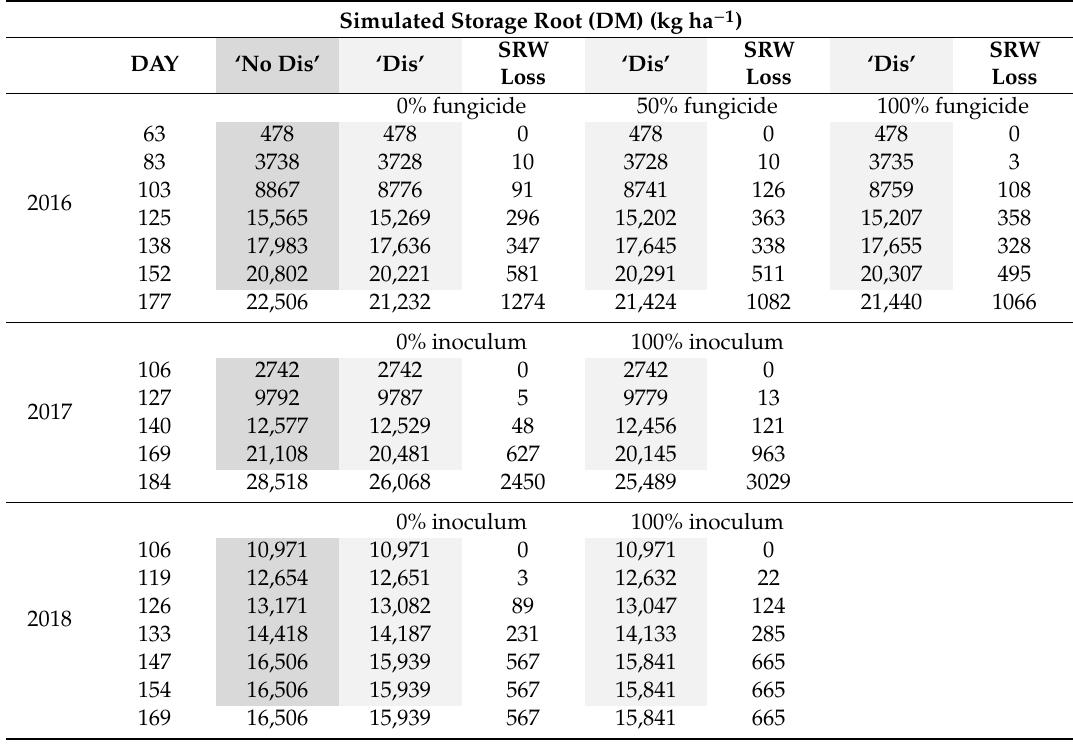
Table 9. Simulated storage root (DM) kg ha − 1 : disease free storage root (“no dis”—Cercospora leaf spot disease ratings not included in the model input files), storage root simulated quantity with Cercospora leaf spot disease ratings included in the model input files (“dis”) and storage root weight (SRW)